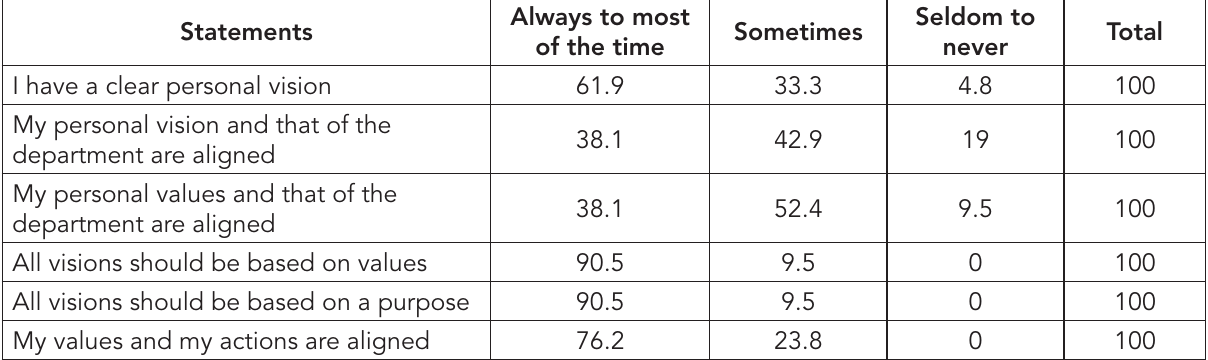
Table 7: Frequencies: Vision and personal vision – Section